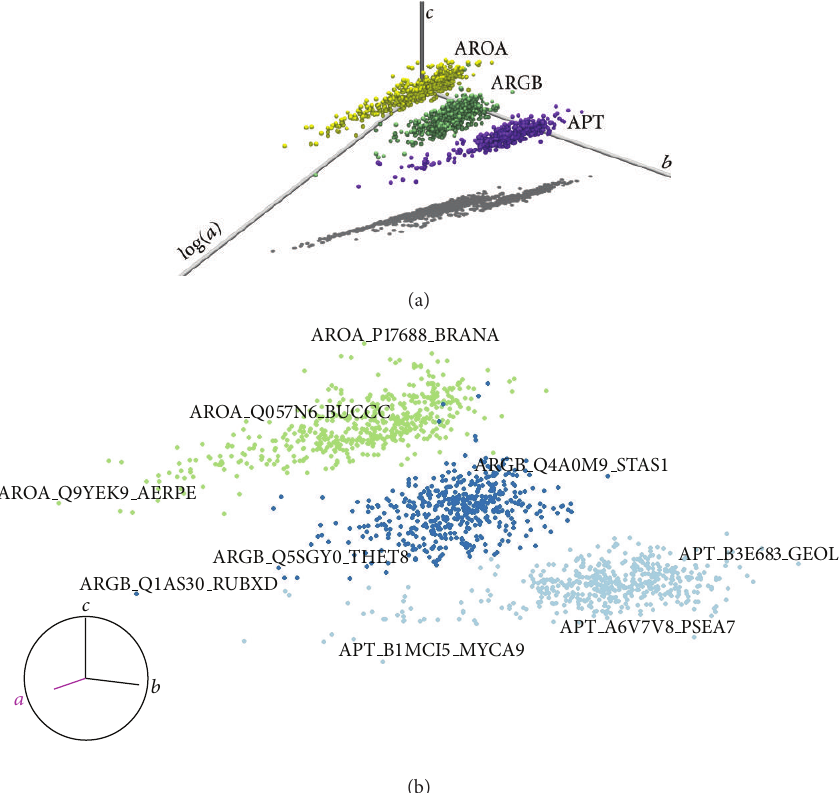
Figure 11: (a) Locus (𝑎, 𝑏, 𝑐) of genes APT, ARGB, and AROA (1803 2-tuple HSRFs) in Dataset 1—HRF PL regression + Canberra distance. (b) GGobi made 2-dimensional projection of locus (𝑎,𝑏, 𝑐) of genes APT, ARGB, and AROA (1803 2-tuple HSRFs) in Dataset 1, with some proteins labeled.